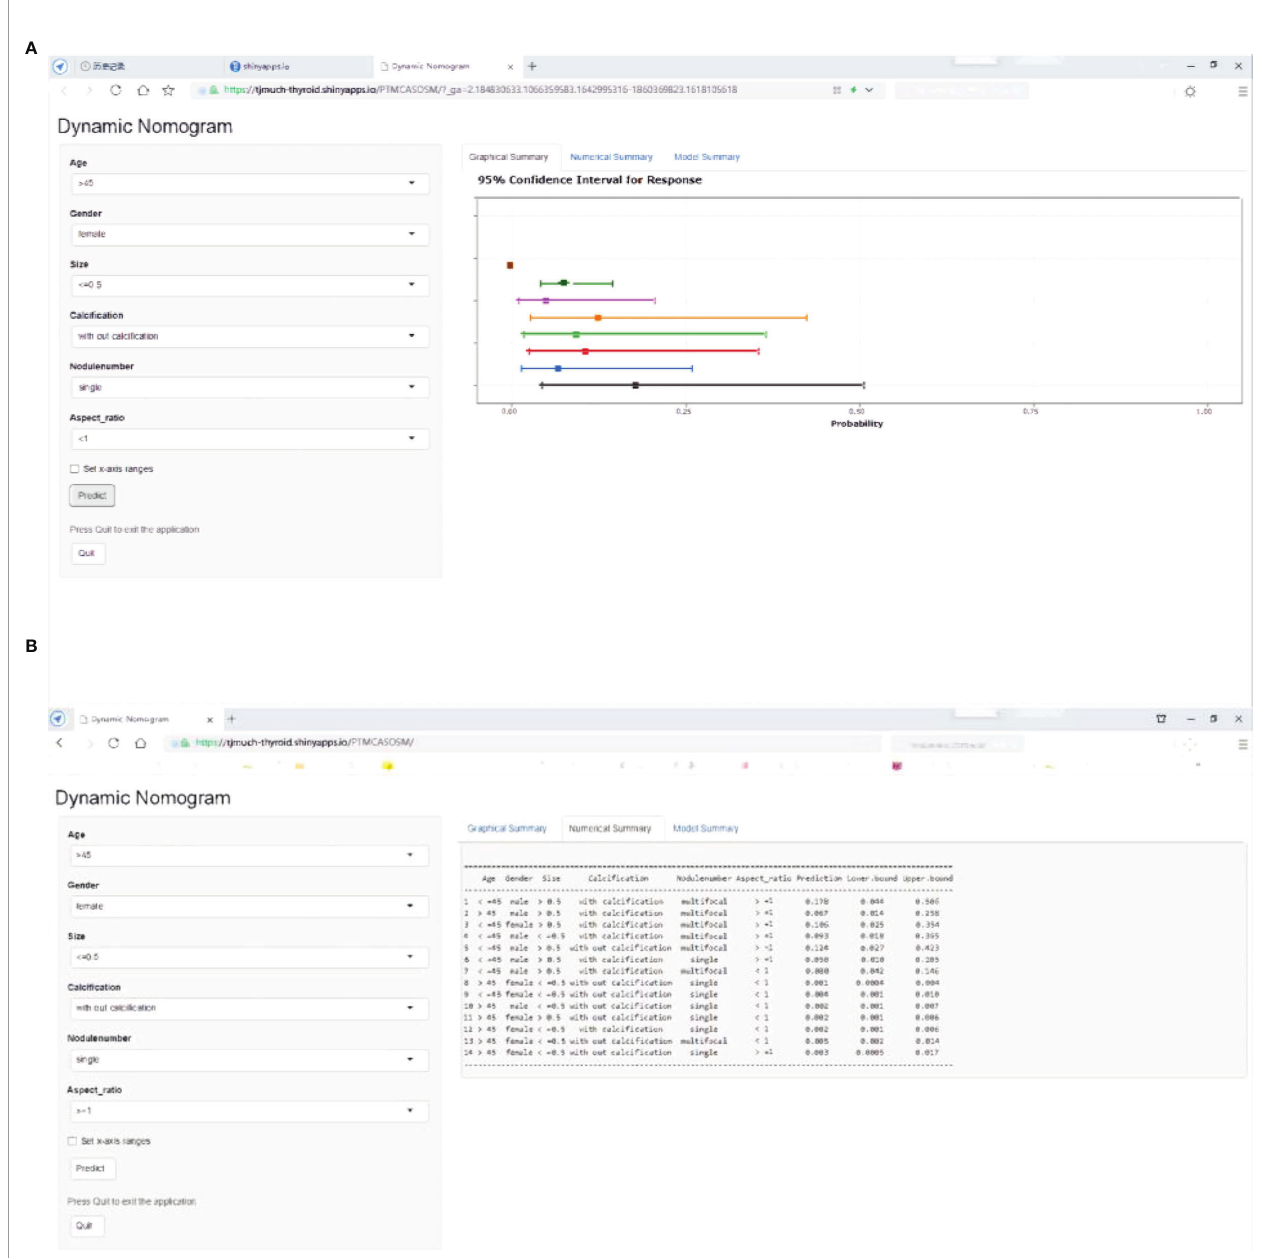
FIGURE 3 | PTMC ASOS nomogram for predicting large-number in cN0 PTMC patients. Dynamic nomogram predicting large-number LNM in cN0 PTMCs. (https:// tjmuch-thyroid.shinyapps.io/PTMCASOSM/). (A) Graphical Summary of PTMC ASOS model. (B) Numberical Summary of PTMC ASOS